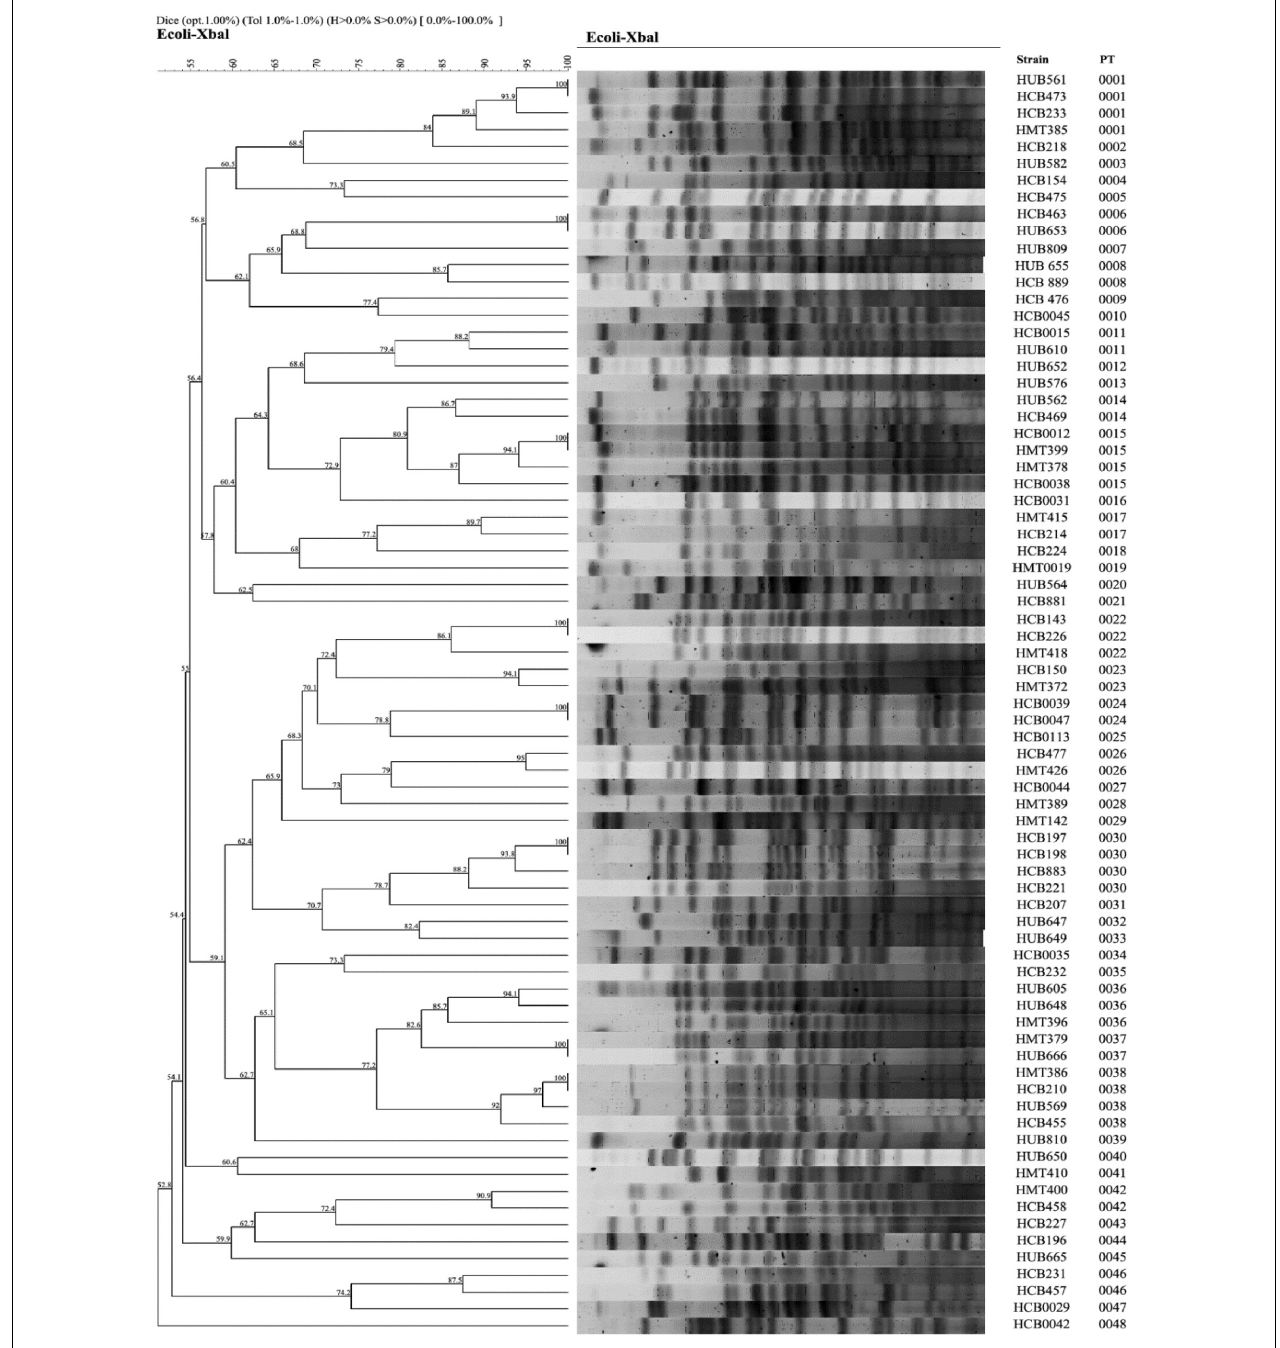
FIGURE 7 | Clonal relationship analysis of the colibactin strains assessed by PFGE using Xba I. PT: